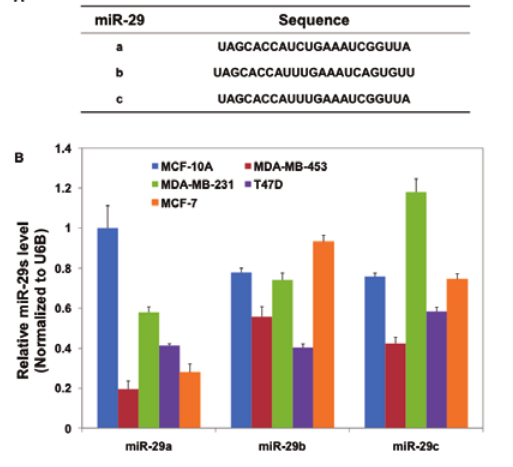
Figure 1: Relative levels of miR-29 in normal mammary epithelia and breast cancer cells. (A) Comparison of miR-29 isoforms. (B) Relative levels of miR-29 were normalized against the level in MCF-10A cell; U6B was used as an internal